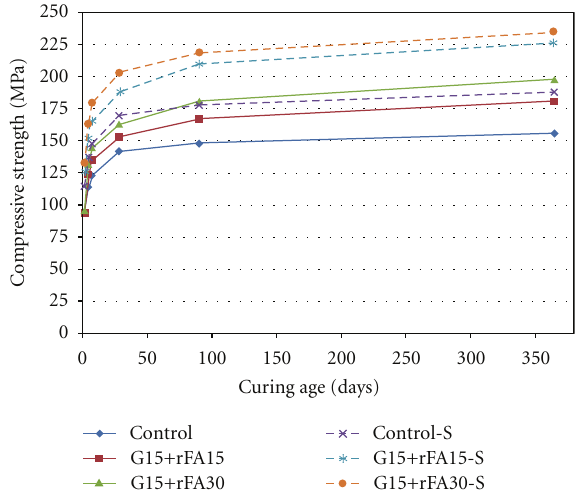
Figure 5: E ff ect of GP on flexural strength of UHPFRC with and without steam